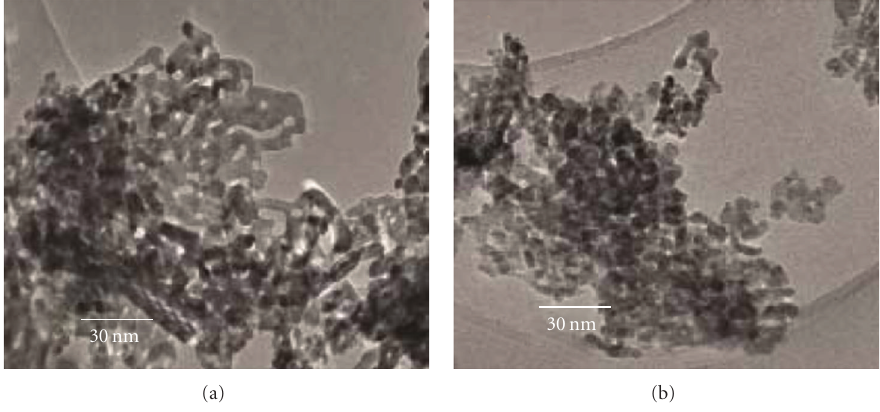
Figure 7: TEM images of (a) pure and (b) 33.3 mol% nickel-doped SnO 2 nanoparticles.